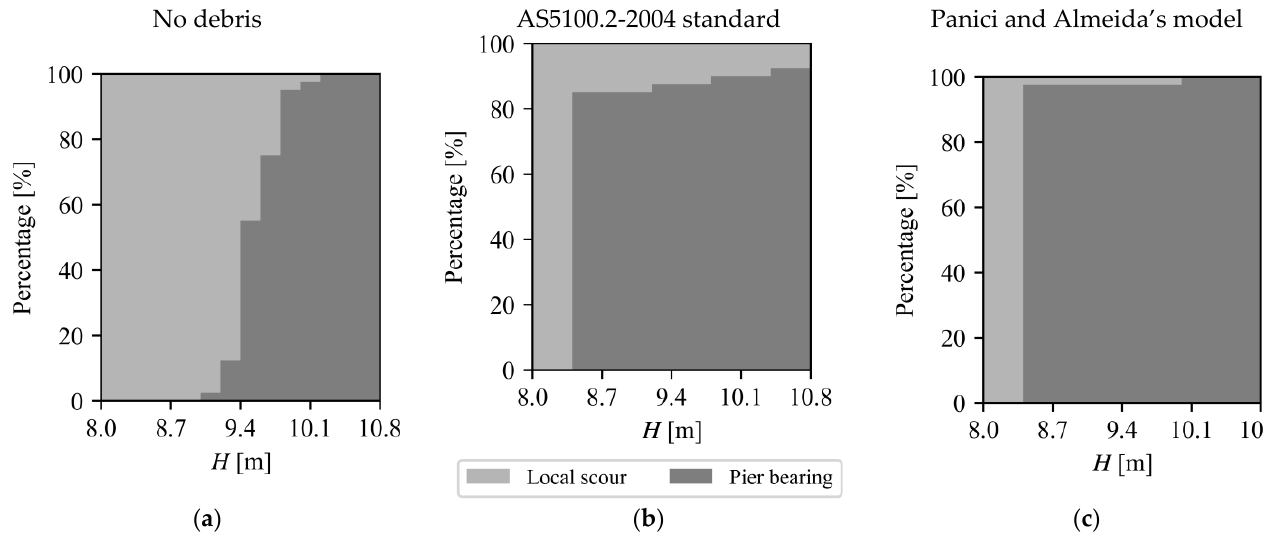
Figure 16. Frequency of occurrence of two leading mechanisms (i.e., local scour and pier bearing failure) within LHS simulations for the ( a ) first, ( b ) second, and ( c ) third debris scenario and the upper prediction bound of the 𝐻 − 𝑣 relationship. Note that the frequencies between 𝐻 = 2 m and 𝐻 = 8 m are omitted, since, in this range, local scour is the leading mechanism.